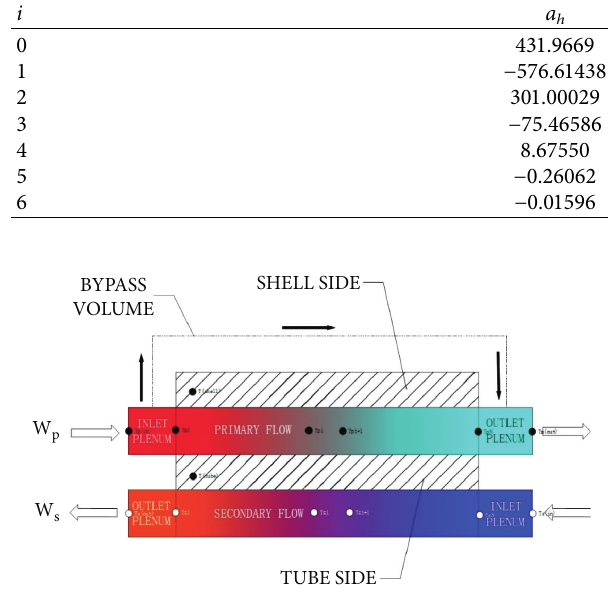
Figure 10: IHX calculation